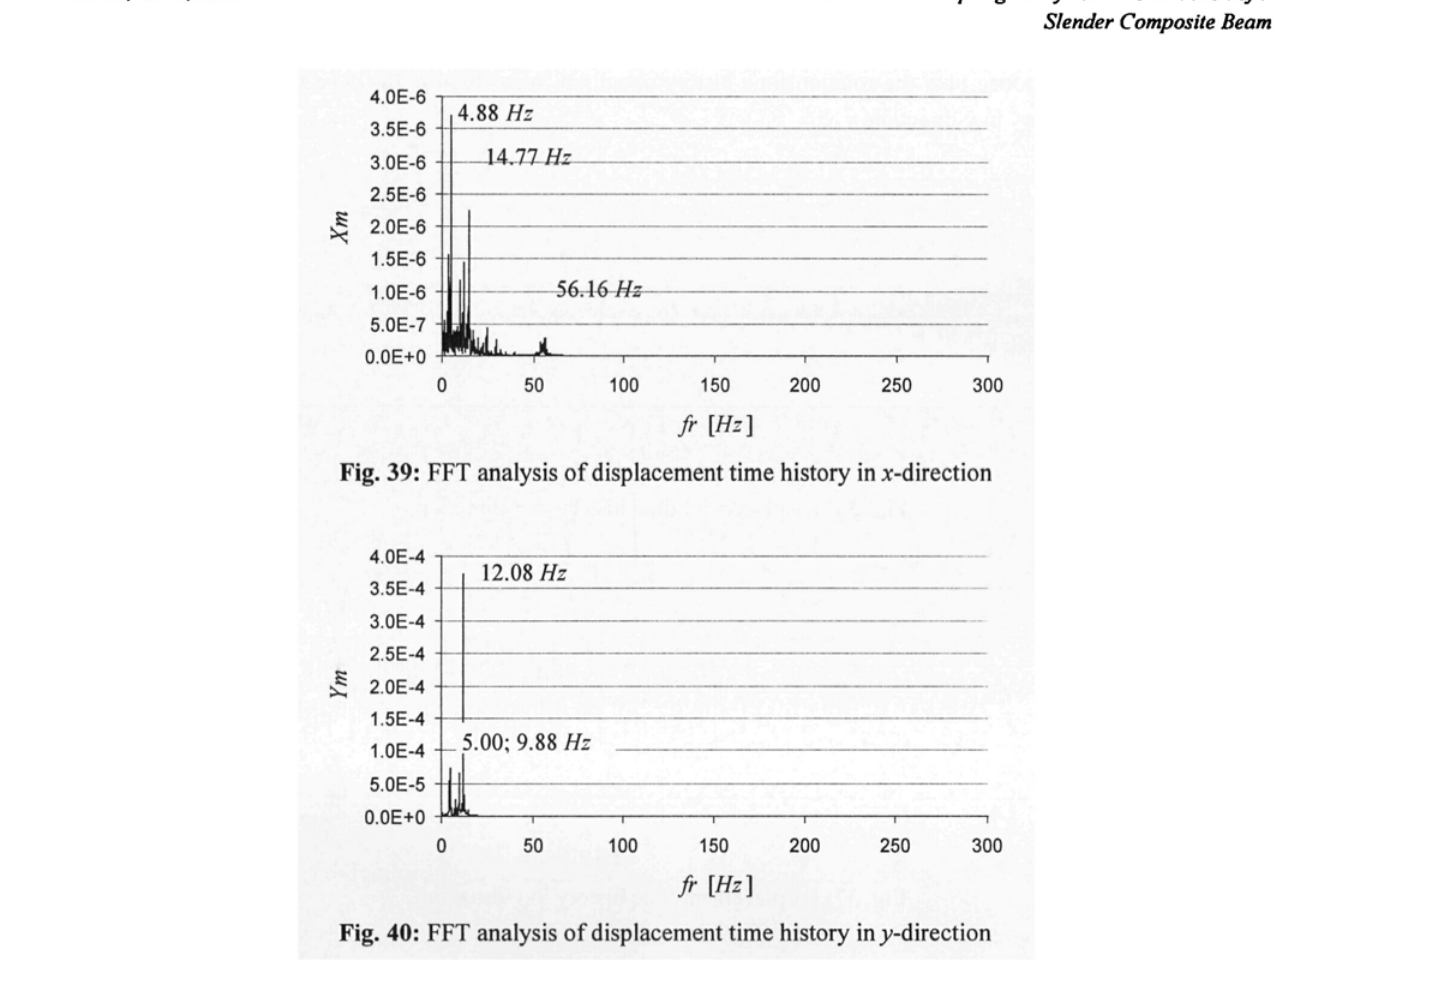
Fig. 40: FFT analysis of displacement time history in ^-direction